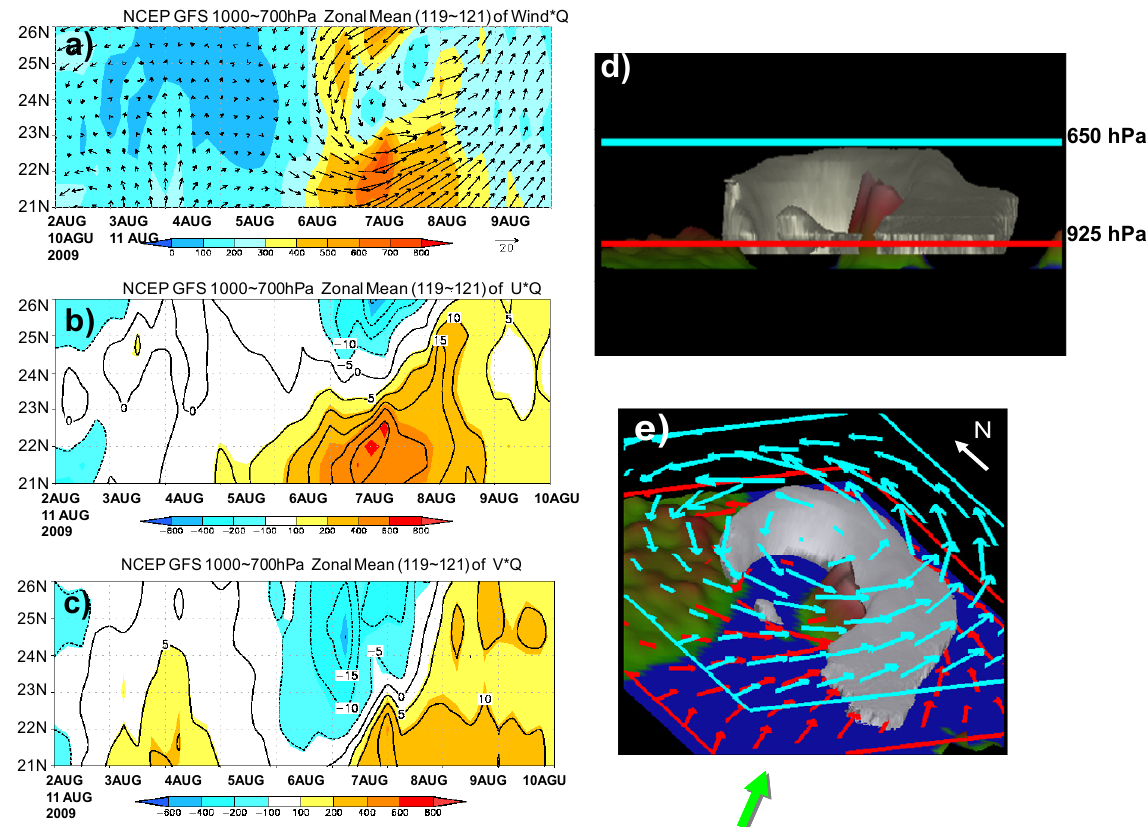
Fig. 4. (a) Temporal variation of average moisture flux (colored) and wind field (arrow) for the zonal mean (119–121 ◦ E) and depth between 1000 and 700hPa deduced from NCEP GFS data. The colored scales represent the magnitude of moisture flux. The lower right corner of arrow denotes the scale of wind speed. (b) Temporal variation of the average moisture flux (colored) and wind speed (contour) between 1000 and 700hPa for the zonal mean (119–121 ◦ E) in E-W direction deduced from NCEP GFS data. The colored scales represent the magnitude of moisture flux. (c) Same as (b) but for in N-S direction. (d) A northwest-southeast vertical perspective views for depth by VIS5D for the moisture flux at 00:00UTC 8 August taken from the direction of the arrow in (e) The grey shading is the moisture flux surface of 550g/kgm/s. (e) Three-dimensional perspective views by VIS5D for the moisture flux at 00:00UTC 8 August. The blue (red) arrow represents the wind field at 650hPa (925hPa). The grey shading is the moisture flux surface of